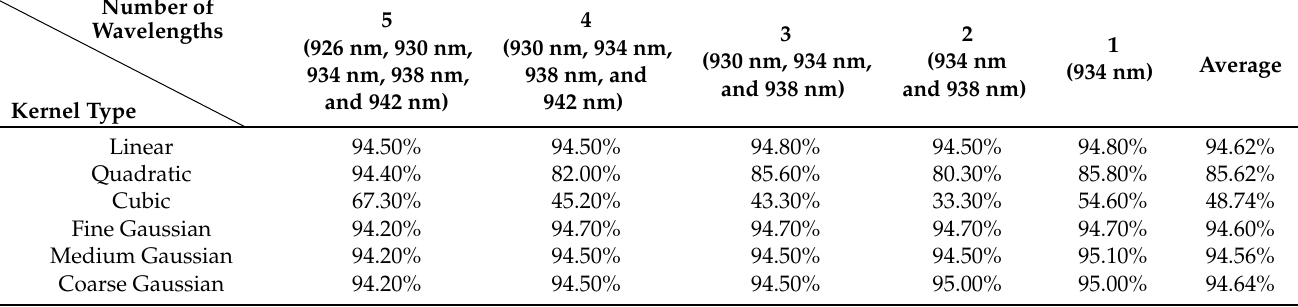
Table 3. Performance of each SVM model in terms of accuracy in each reduction of the number of wavelengths.